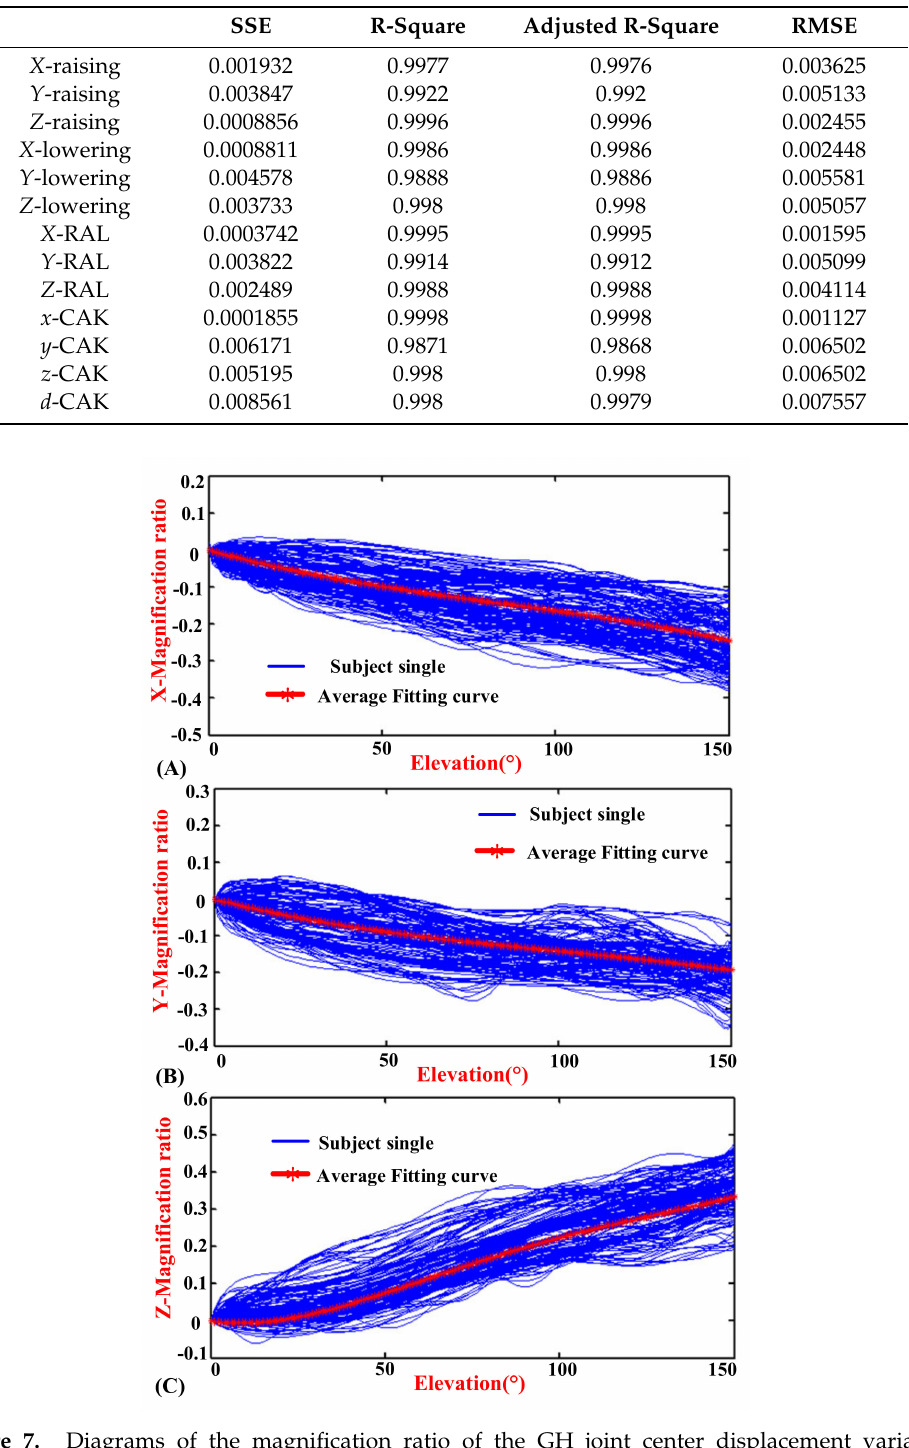
Figure 7. Diagrams of the magnification ratio of the GH joint center displacement variable quantity relative to the thorax coordinate system during humeral elevation in lowering phase. ( A ) X -Magnification ratio and elevation angle. ( B ) Y -Magnification ratio and elevation angle. ( C ) Z -Magnification ratio and elevation